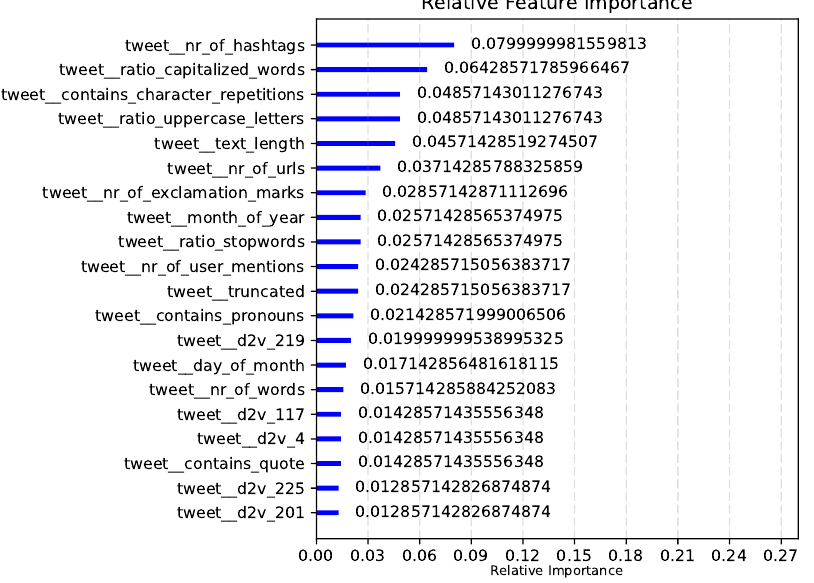
Figure 8. Feature importance for Scenario 1 (tweet level features only), as computed by XGBoost.